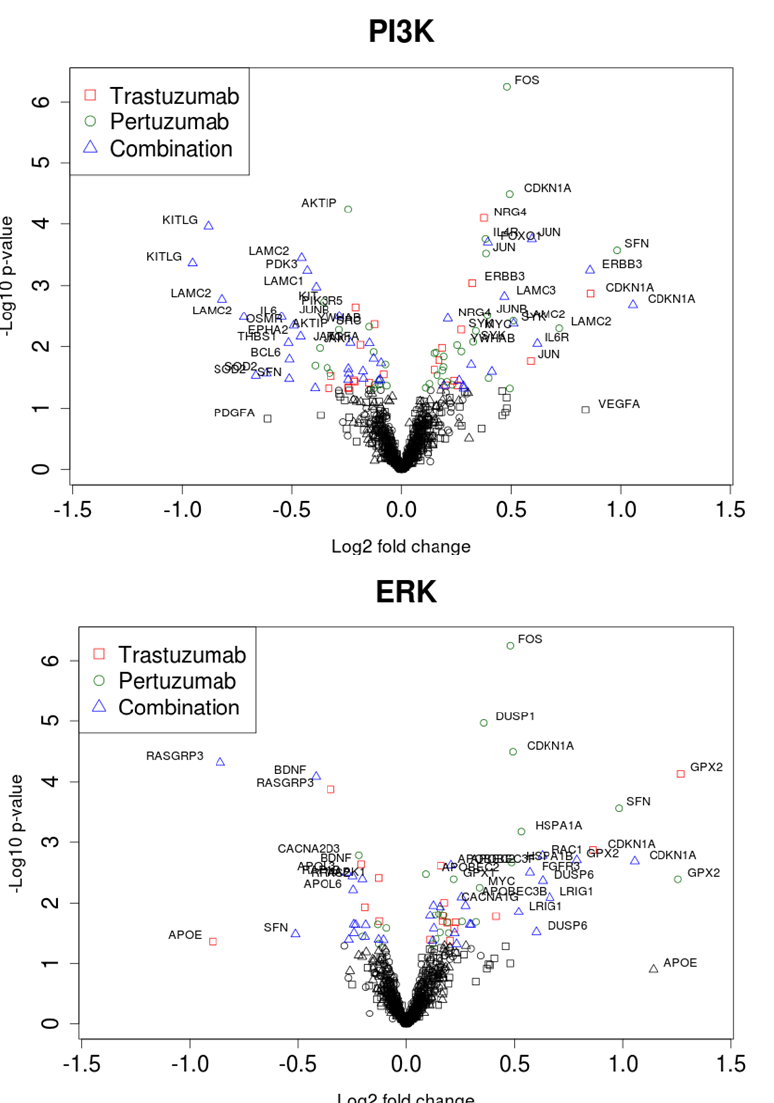
Figure 7. Volcano plots of gene expression related to PI3K/AKT ( A ) and ERK1/2 ( B ) pathways during trastuzumab, pertuzumab, and their combination treatment of SKOV3 ovarian xenograft tumour